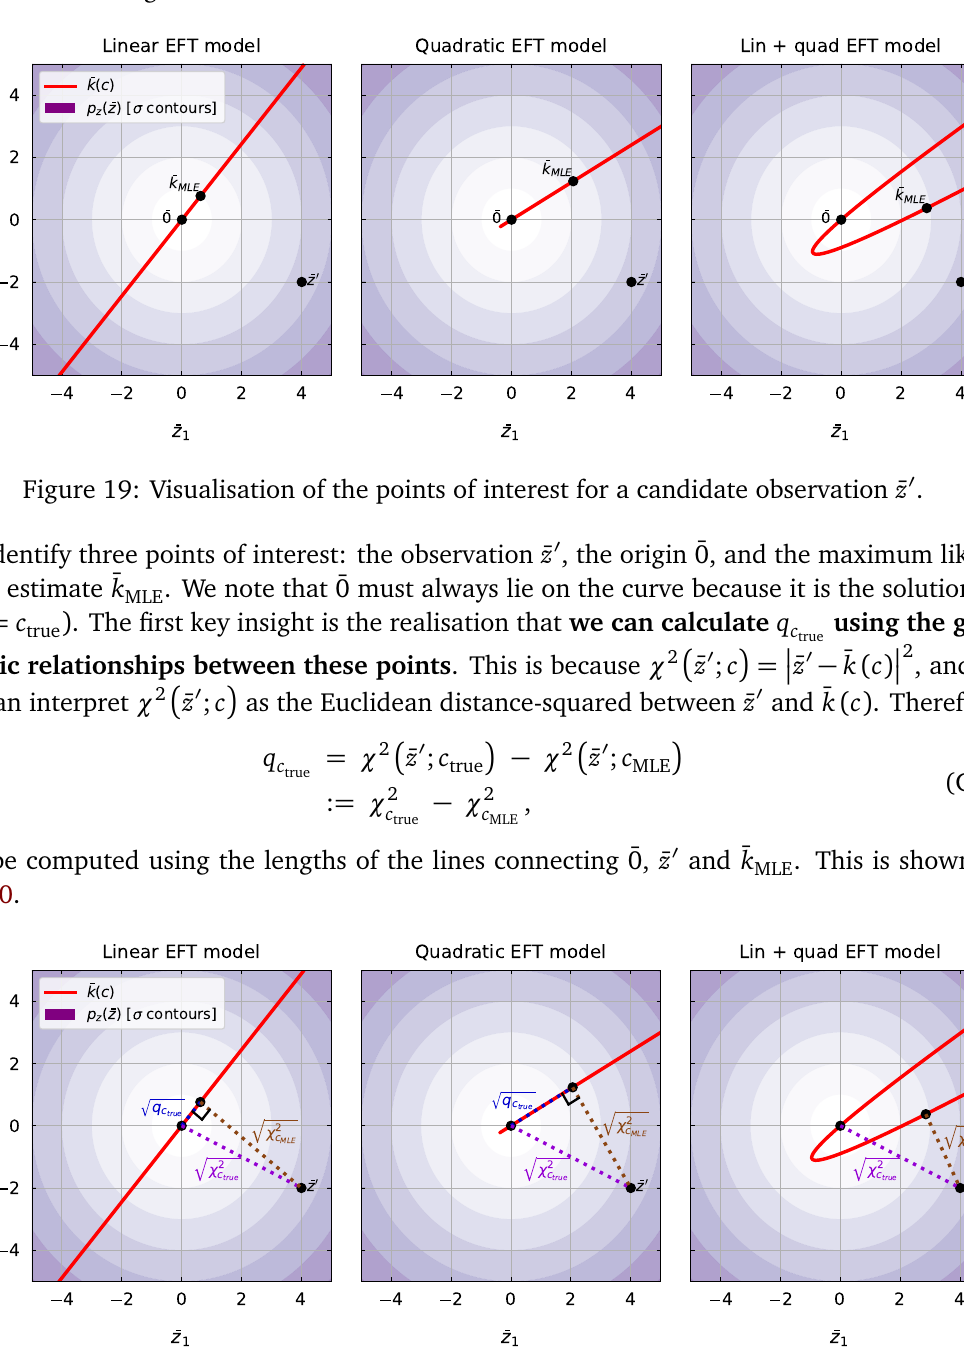
is calculated for a candidate observation c true